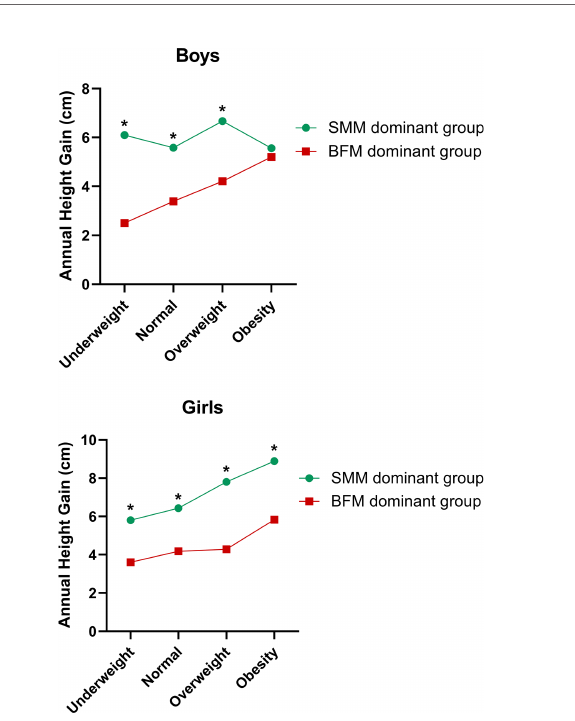
FIGURE 4 | Spearman ’ s correlation analysis with height gain and gains of SMM in different parts of the